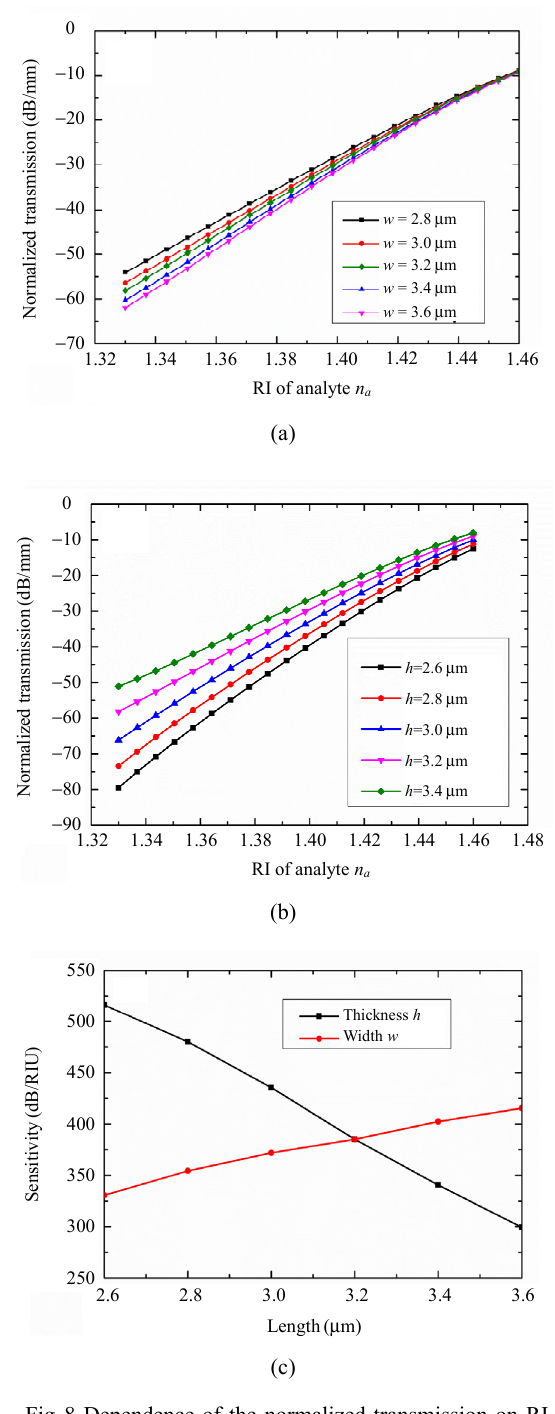
Fig. 8 Dependence of the normalized transmission on RI of the analyte for different (a) waveguide widths, h = 3.2 μ m, (b) waveguide thicknesses, w =3.2 μ m, and (c) the sensitivity of the sensor varies with the waveguide width and waveguide